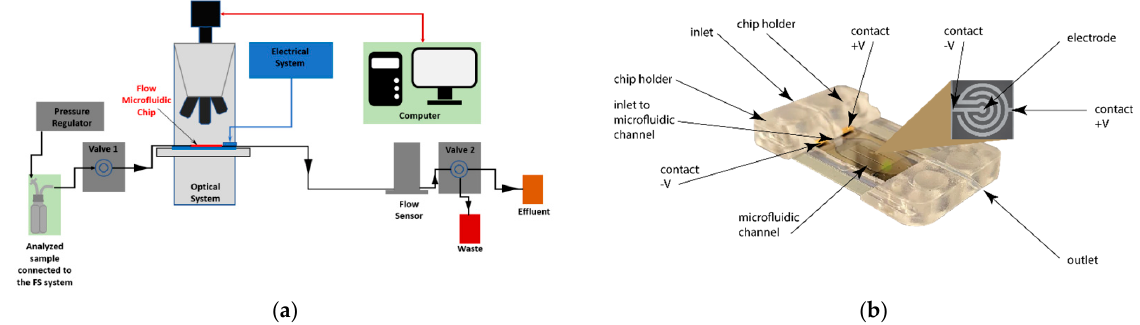
Figure 2. The schematic of the Fluid-Screen (FS) microbial capture and separation system. ( a ) The overall schematic of the FS System operation. The influent sample enters the chip. When the electric field is turned on, bacteria are captured on the electrodes (Figure 4). After the electric field is turned off, the effluent sample is collected. Sample processing of 1 mL through FS System takes approx. 4 min. In addition, Fluid-Screen has developed an automated method to detect and quantify the number of captured biological particles. Figure 2a from [17], reproduced under a Creative Commons Attribution 4.0 International License. ( b ) The Schematic of the FS Flow Microfluidic Chip with a visible electrode.